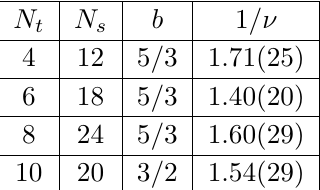
N (cid:14) t =a 2 (cid:12) t c 0